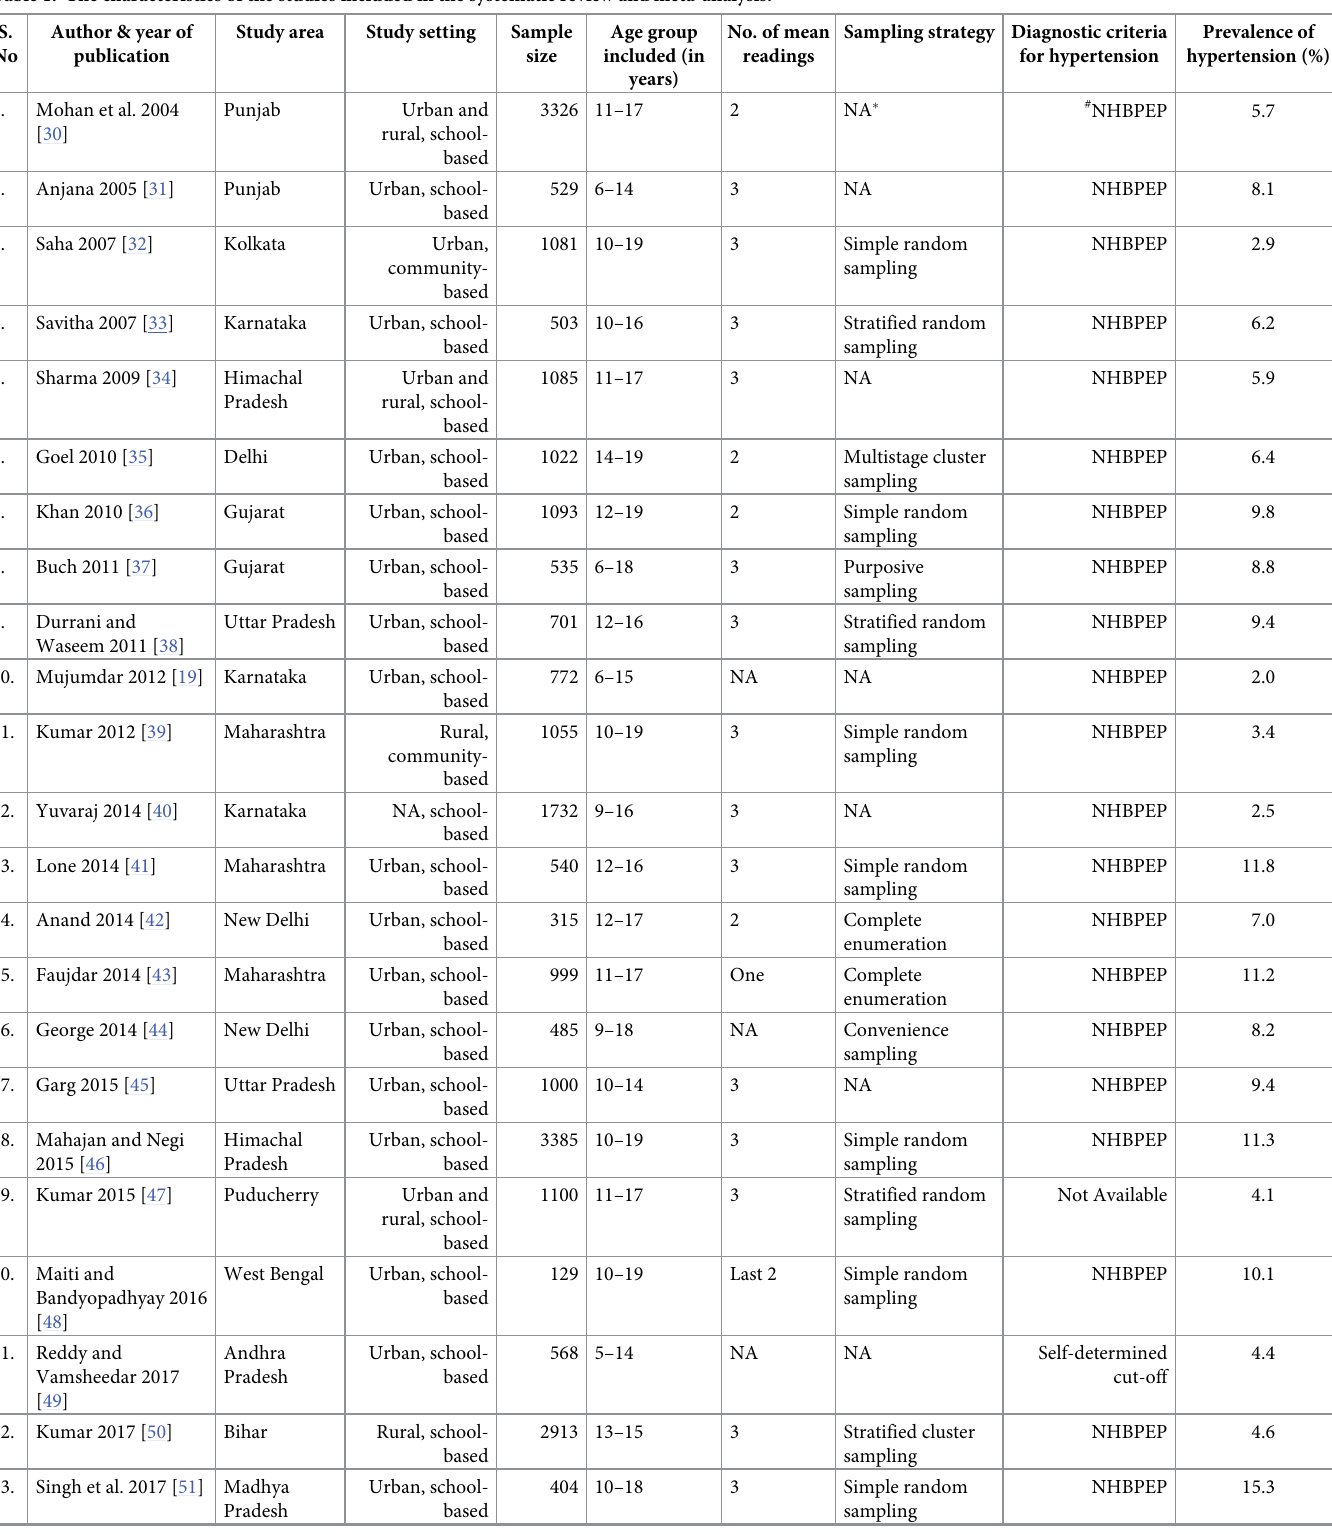
Table 1. The characteristics of the studies included in the systematic review and